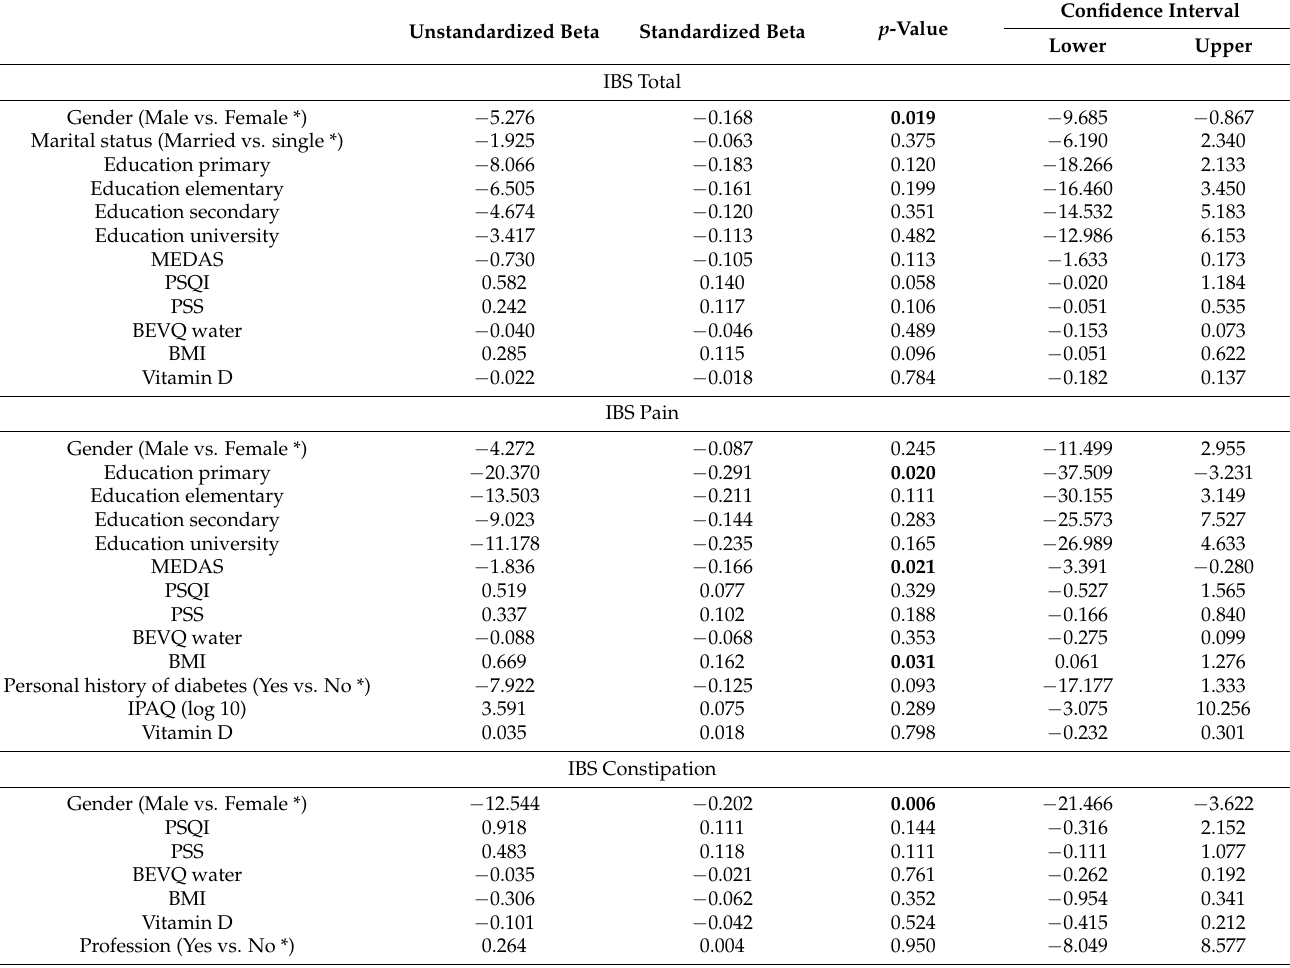
Table 4. Multivariable linear regression